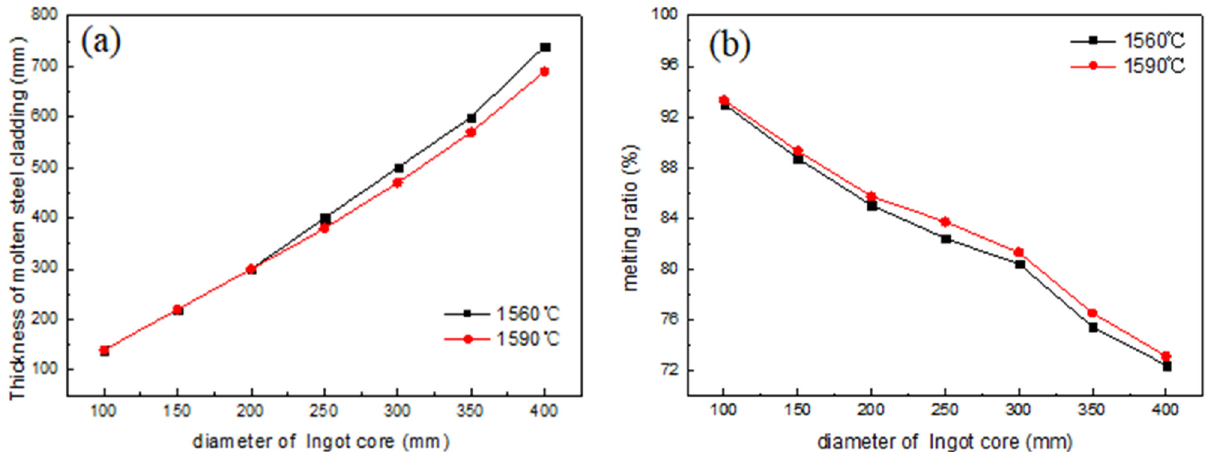
Figure 11: E ff ect of di ff erent casting temperatures on coated steel ingots: ( a ) e ff ect of casting temperature on coating thickness; ( b ) e ff ect of casting temperature on the interfacial melting